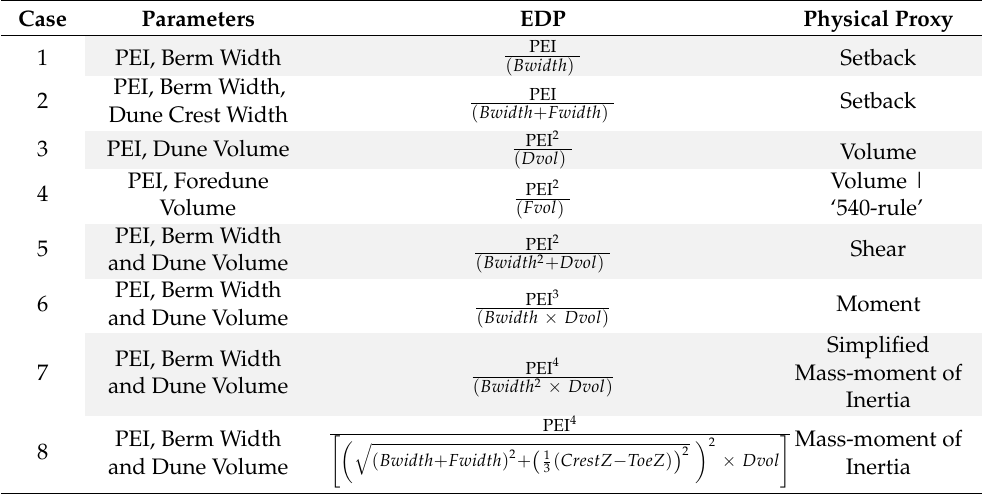
Table 5. Considered EDPs, underlying parameters (IM and R f ) and physical